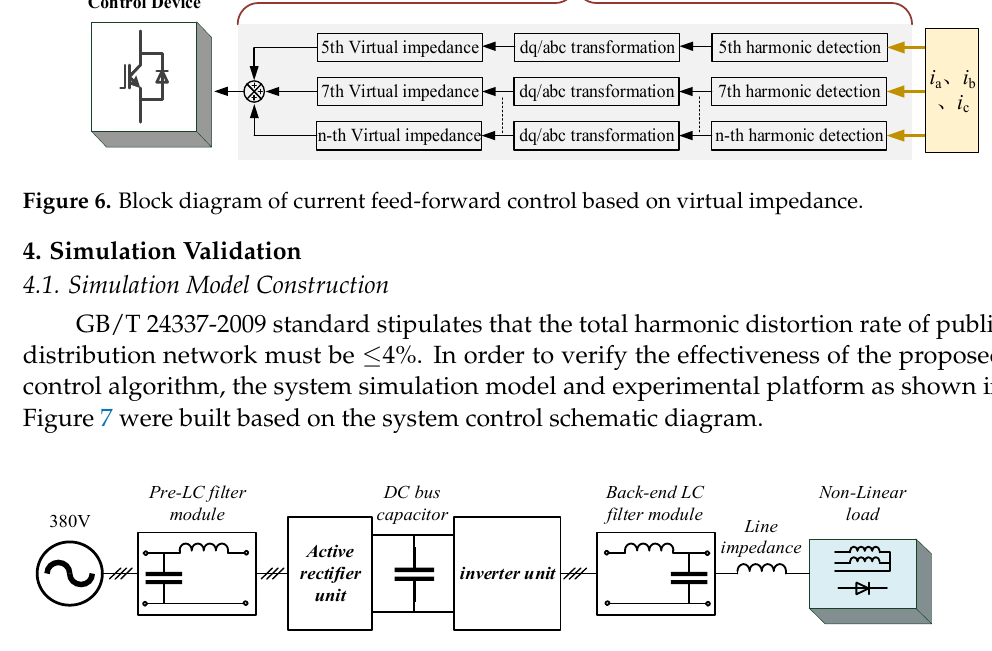
Figure 7. The system simulation model and experimental platform. Table 1 shows the parameter settings of the system simulation model. Table 1. System parameters.